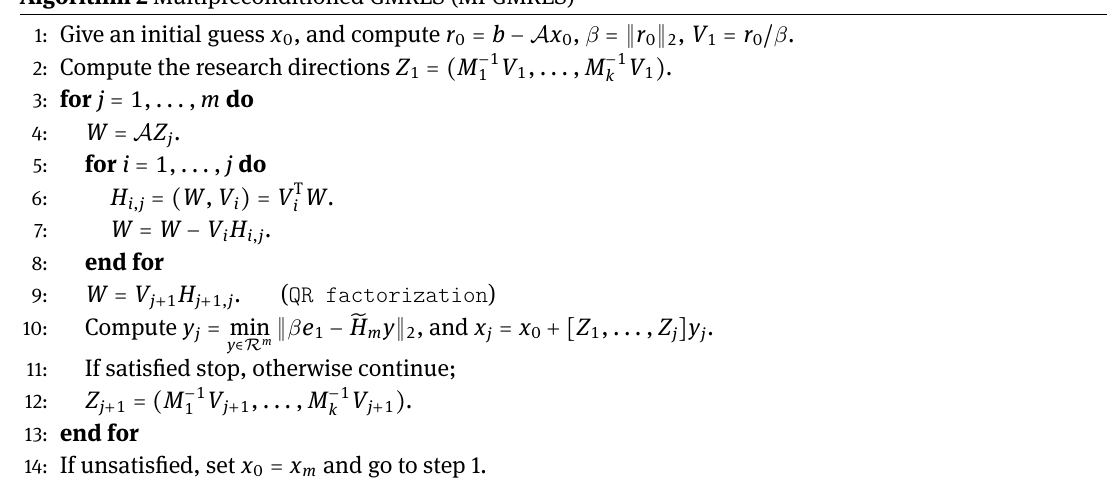
Algorithm 2 Multipreconditioned GMRES